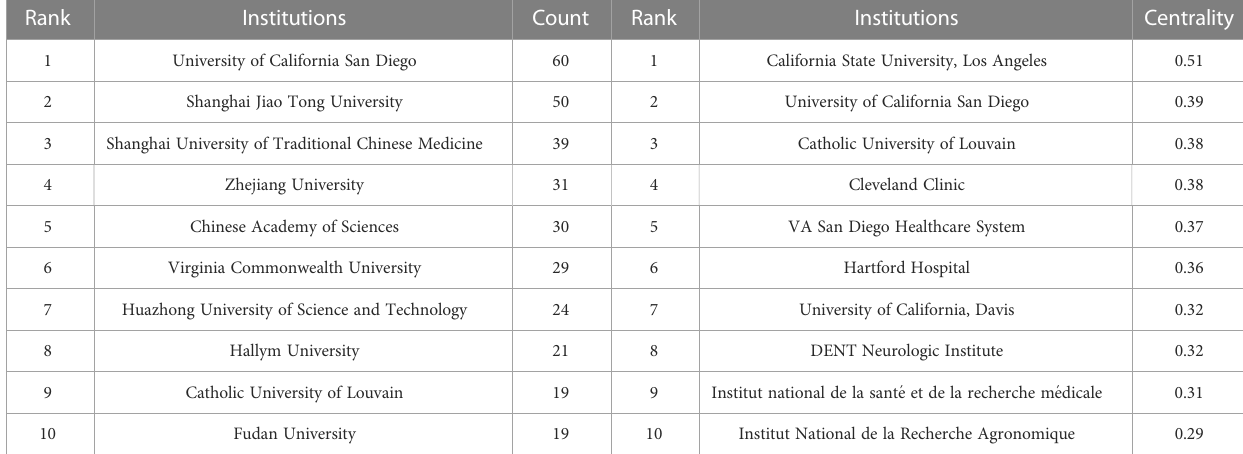
TABLE 4 Top 10 institutions conducting the gut-liver axis in NAFLD by volume and centrality.